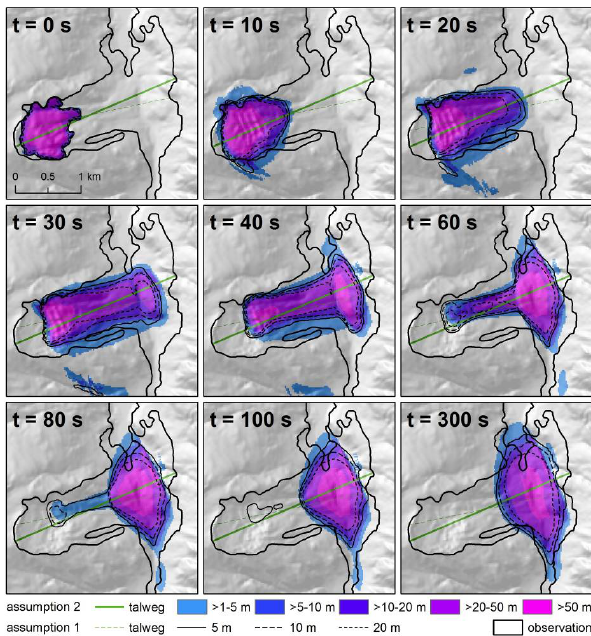
Fig. 9: Time series of flow depth distribution simulated with φ = 35° and δ = 22° at a cell size Fig. 9. Time series of flow depth distribution simulated with φ = of 20 m, assuming talweg 2. The computed flow depth assuming talweg 1 is shown as 35 ◦ and δ = 22 ◦ at a cell size of 20m, assuming talweg 2. The computed flow depth assuming talweg 1 is shown as reference (see reference (see Fig. 6). Fig. 6).